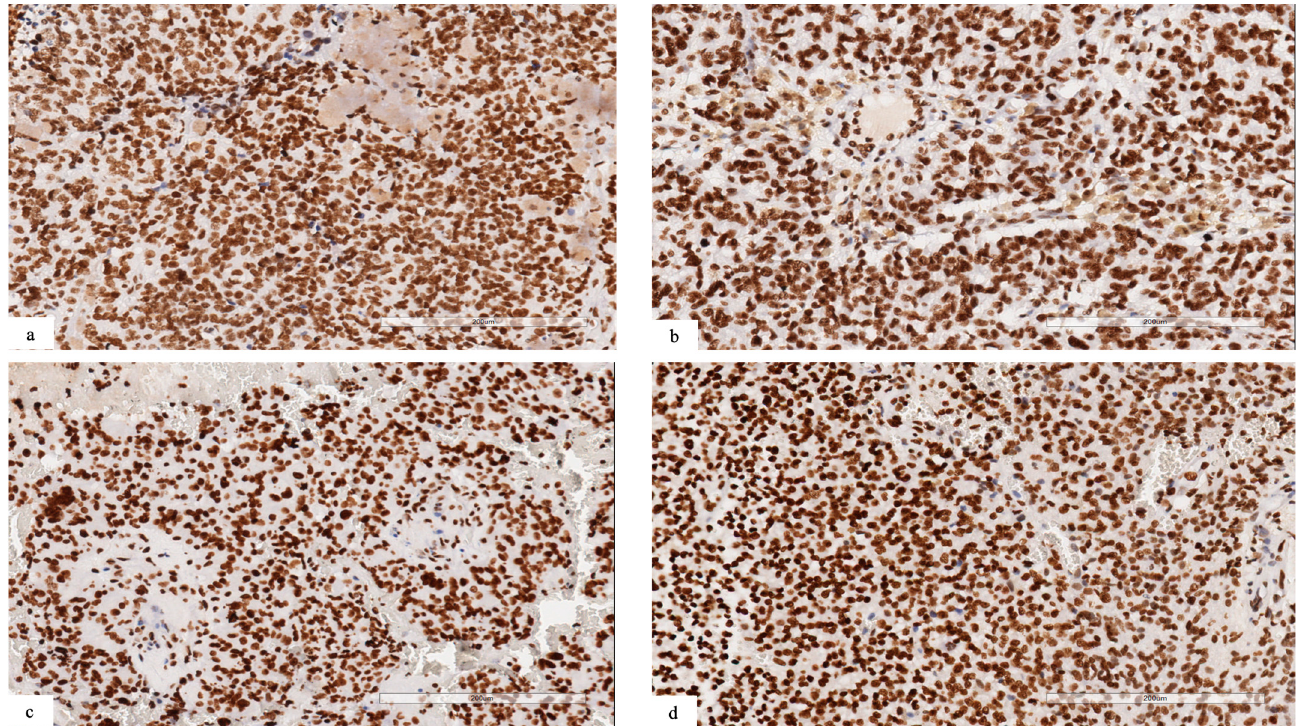
Figure 2. ( a – d ) Immunohistochemical analysis revealing retained expression for dimethyl histone H3K36 in neoplastic cells (( a ) patient #1; ( b ) patient #2; ( c ) patient #3; ( d ) patient #4).